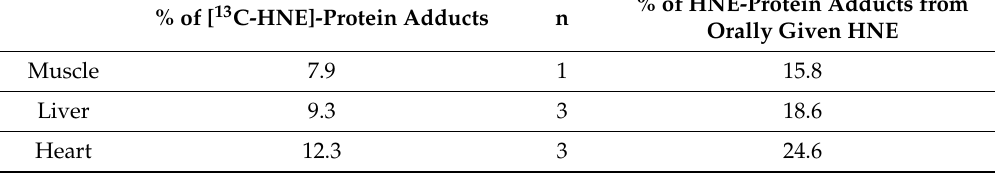
Table 1. HNE-protein adducts from orally given HNE: Semi-quantitative evaluation of 13 C-labeled- HNE-protein adducts: % of labeled HNE-protein adducts among total HNE-protein adducts. As rats were given an equimolar mixture of labeled and unlabeled HNE, the percentage of HNE-protein adducts from orally given HNE is quantified as twice the percentage of 13 C-labeled-HNE-protein adducts. The results are the mean of n animals. % of HNE-Protein Adducts from % of [ 13 C-HNE]-Protein Adducts n Orally Given